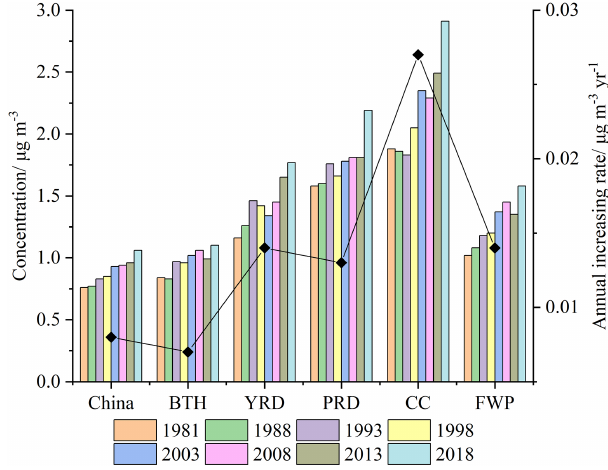
Figure 8. The interannual changes of SOA in China and the key